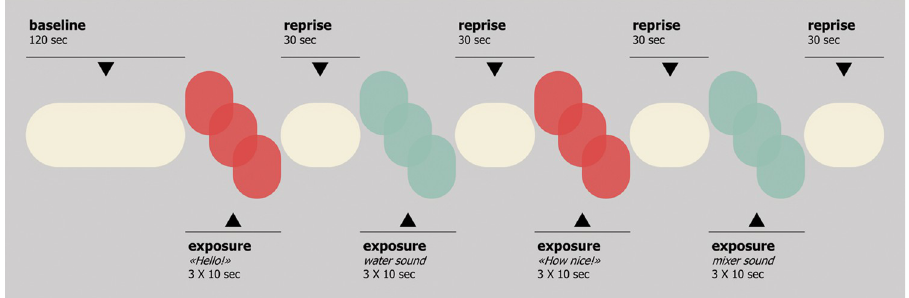
Fig 1. Task overview. Note. The order of the stimuli during the Exposure episodes was counterbalanced among subjects, keeping the alternation between human and non-human sounds. As the task was conducted with Italian mother-infant dyads, the human sounds were “Ciao” (for “Hello!”) and “Che bello!” (for “How nice!”).